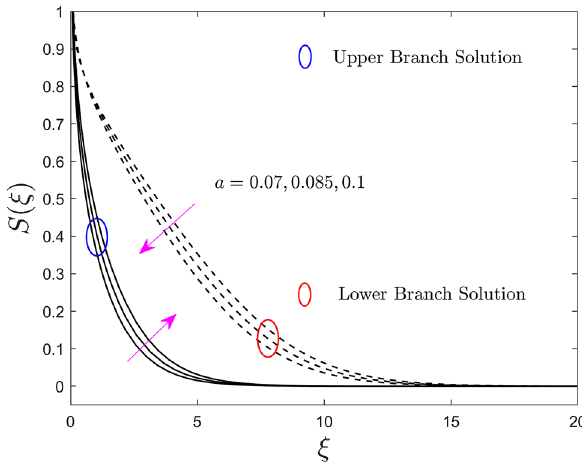
Figure 4. Effect of needle size a on the concentration profiles S (ξ) .